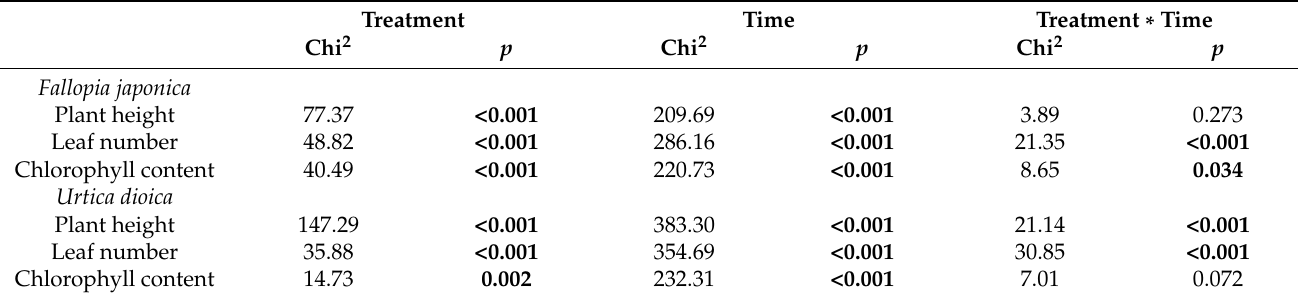
Table 1. Results of the lmer models for both Fallopia japonica and Urtica dioica performance parameters across the growing season of 2021. Chi-squared and corresponding p -values for all analyzed param- eters are given. Treatment represents the effect of the copper treatment; time represents the effect of the time over the season when the parameter was recorded; and treatment * time represents the interaction between both parameters. Significant values below the level of 0.05 are printed in bold.